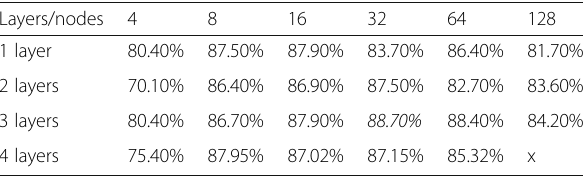
Table 3 DNN regression performance for different numbers of hidden layers and nodes per